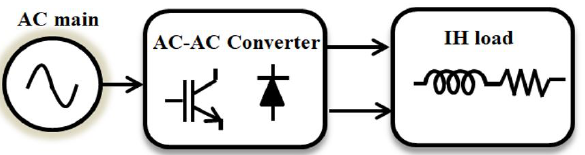
Figure 7. Block diagram of the single stage power conversion topology.